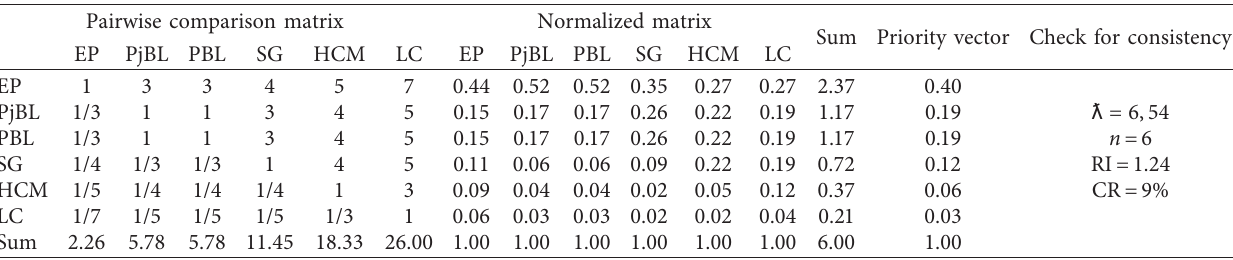
Table 12: Pairwise comparison matrix of learning strategies with respect to the Criterion “SS4. Adaptability, initiative, and reactivity.” Pairwise comparison matrix